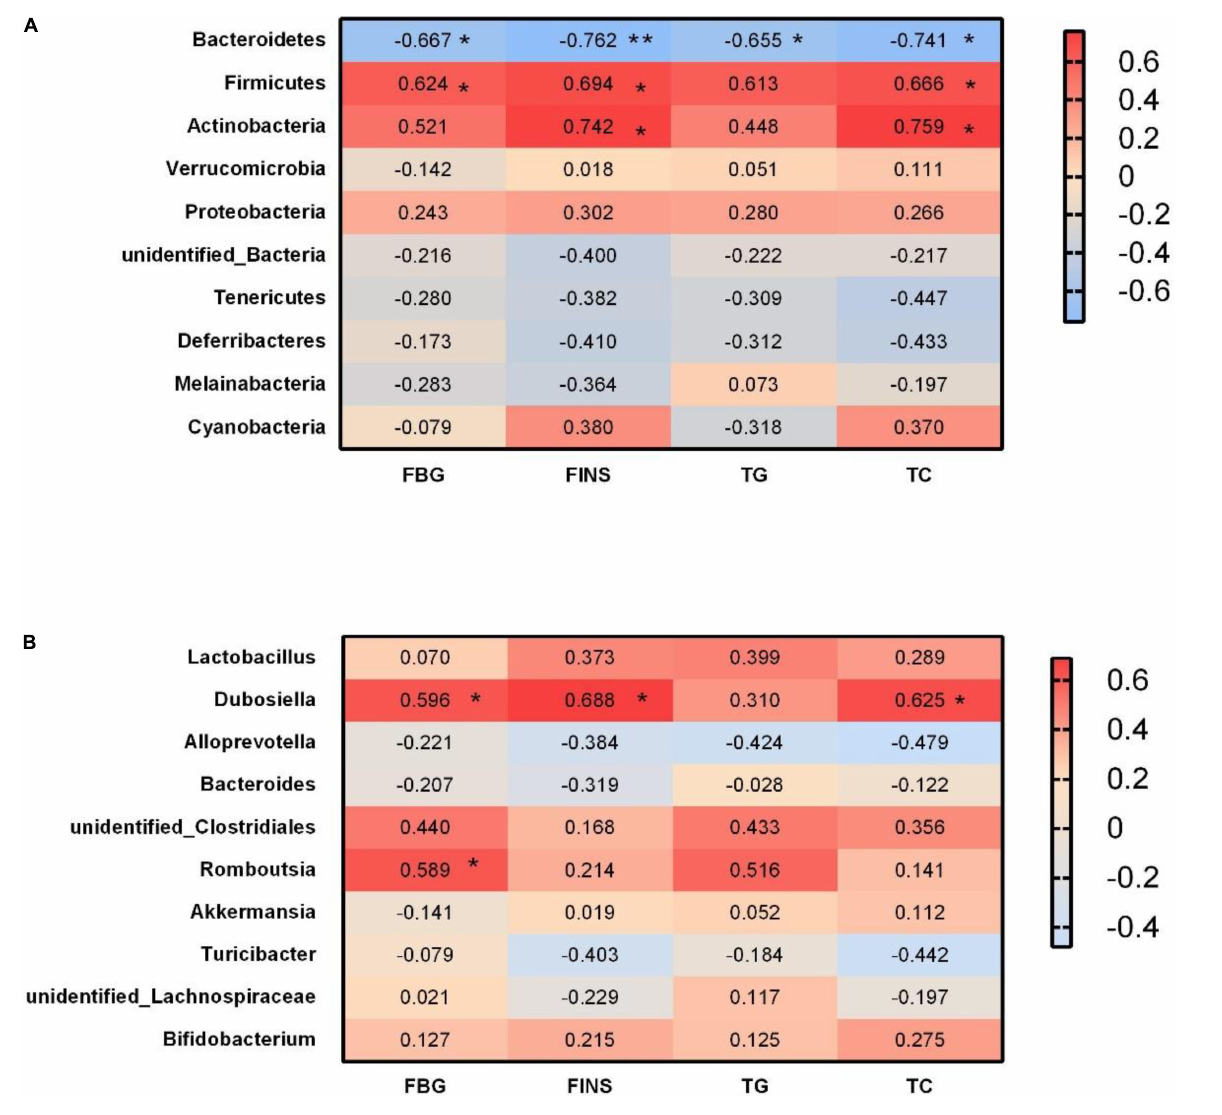
FIGURE 10 | Correlations between glycolipid metabolism indicator and bacterial abundance. (A) Heat map of Spearman correlations between the levels of metabolites/components and the abundances of gut microbial phyla. (B) Heat map of Spearman correlations between the levels of metabolites/components and the abundances of gut microbial genera. FBG, fasting blood glucose; FINS, fasting insulin; TG, triglyceride; TC, total cholesterol. * p < 0.05, ** p <